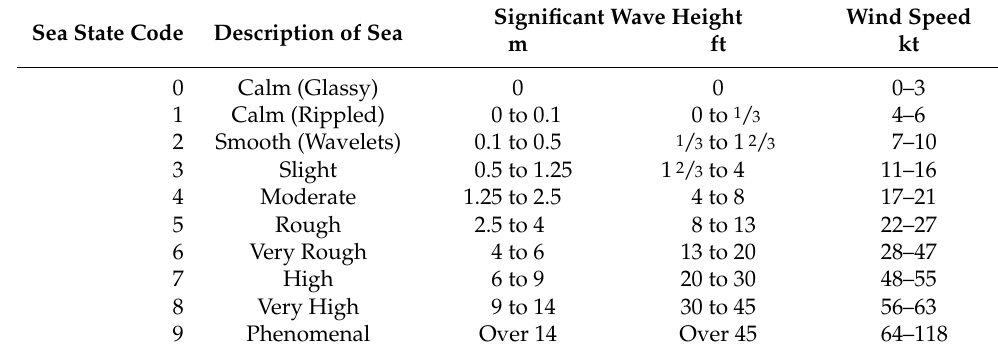
Table A3. Douglas sea state scale from World Meteorological Organization (WMO)